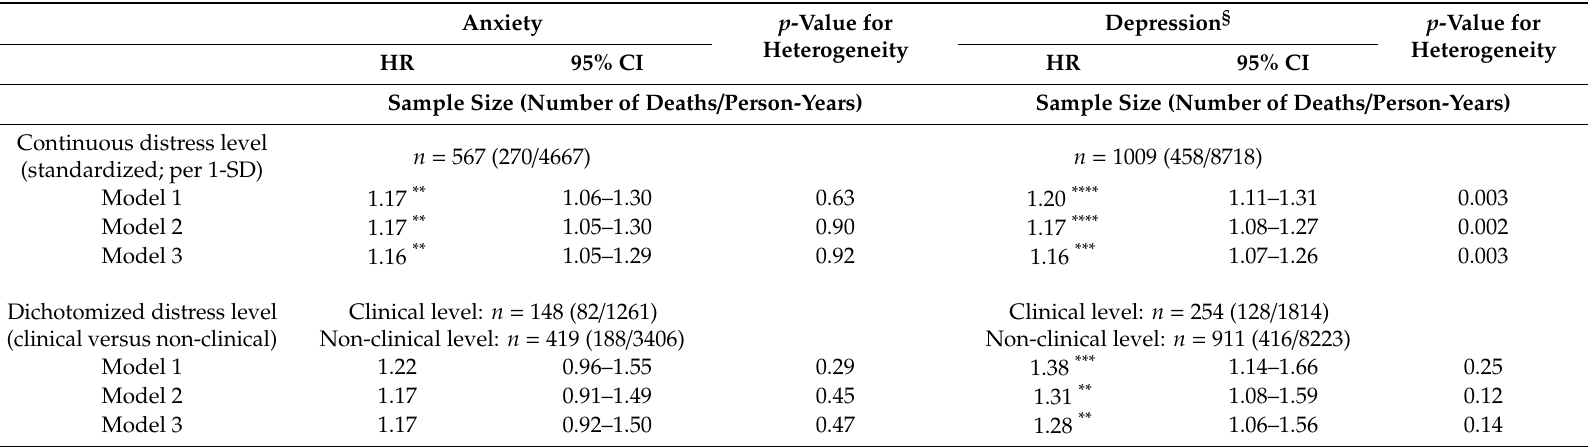
Table 3. Meta-analysis of the association of post-diagnosis anxiety and depression symptoms with overall mortality risk over up to 28 years of follow-up in the NHS and HPFS